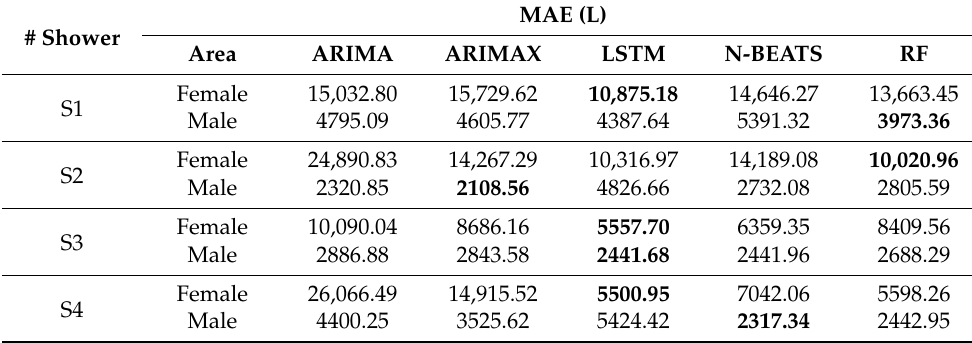
Table 6. MAE of models (bold indicates the best result for corresponding shower room and gender).